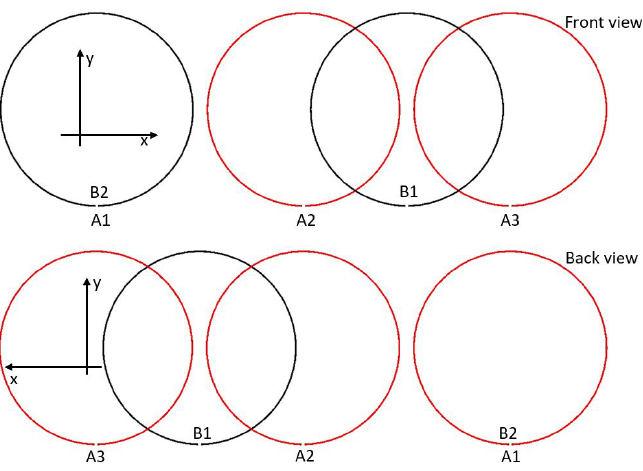
Figure 4. Case 2: geometry analyzed for Case 2. In red the transmitting coils and in black the receiving